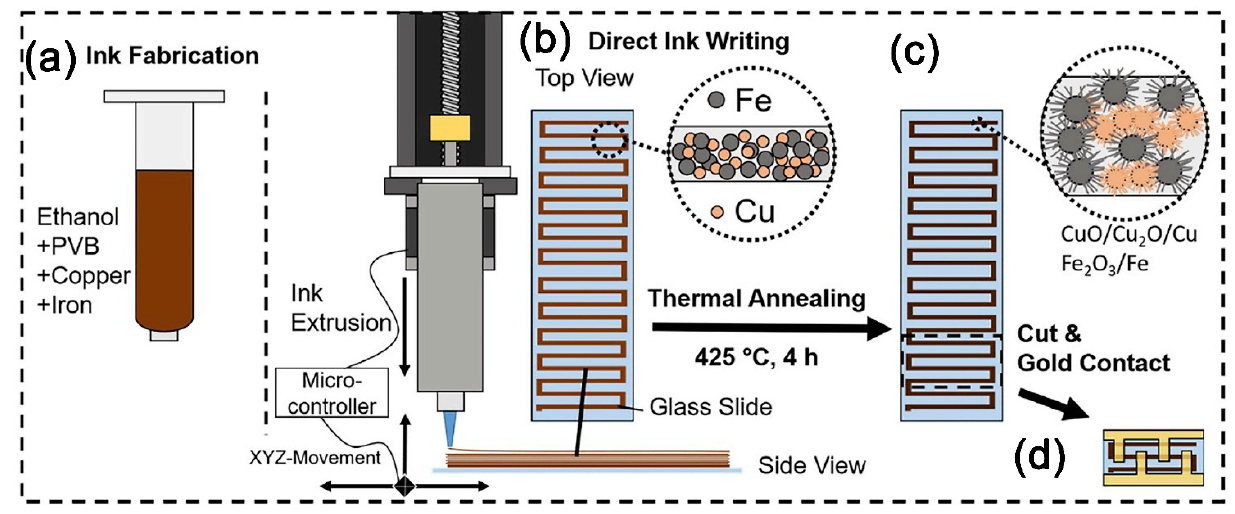
Figure 4. Schematic sensor fabrication process by 3D printing: ( a ) ink fabricated by mixing Cu and Fe microparticles in ethanol, stirring in PVB until a homogeneous state, then the ink is filled into the printer cartridge; ( b ) direct ink writing via piston-driven syringe pumps in a 3D-printing setup; layer by layer building of meandering Cu-Fe stripes; ( c ) The glass slide with the printed object is placed in an oven at air at 425 ° C for 4 h where the metal oxide nanostructures are formed; ( d ) Single sensor devices are coated with Au and then cut for further electrical and sensor investigations.